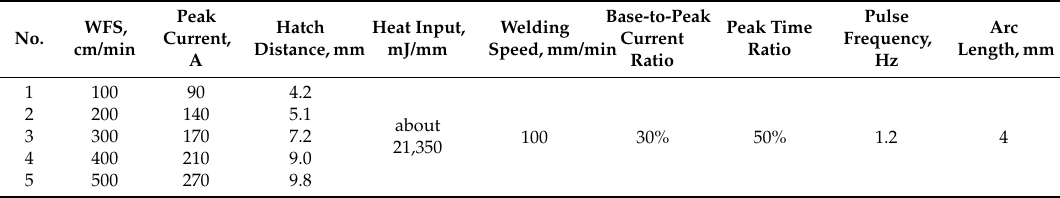
Table 1. Deposition parameters of WAAM.